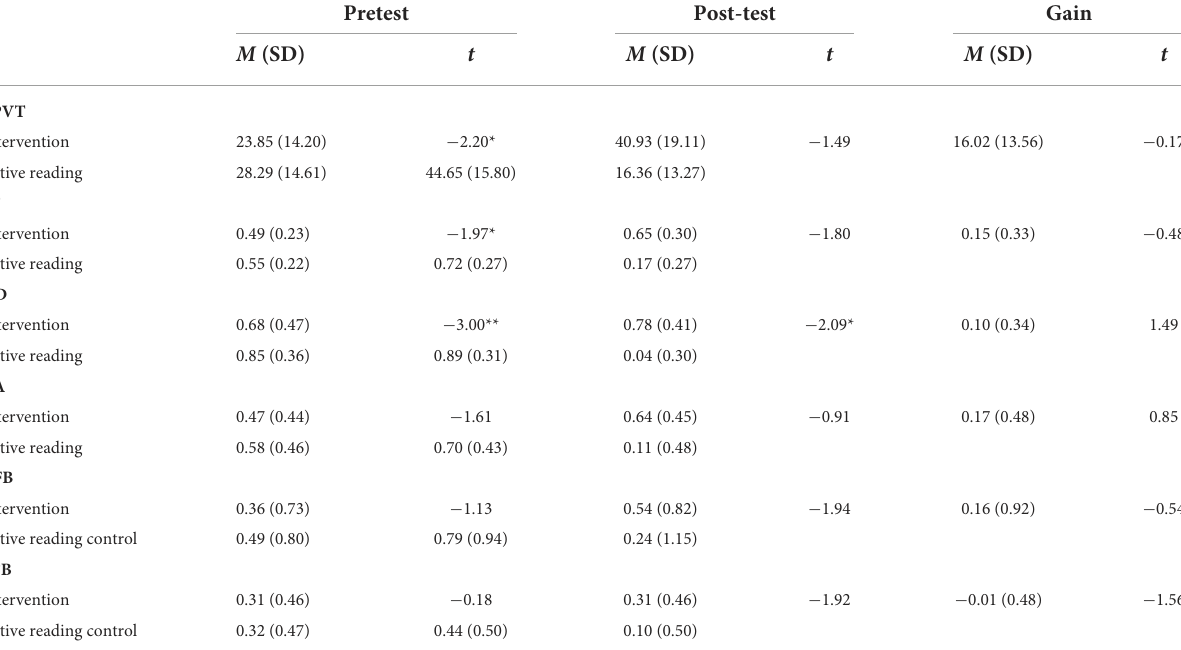
TABLE 2 Session performance for intervention and active reading control